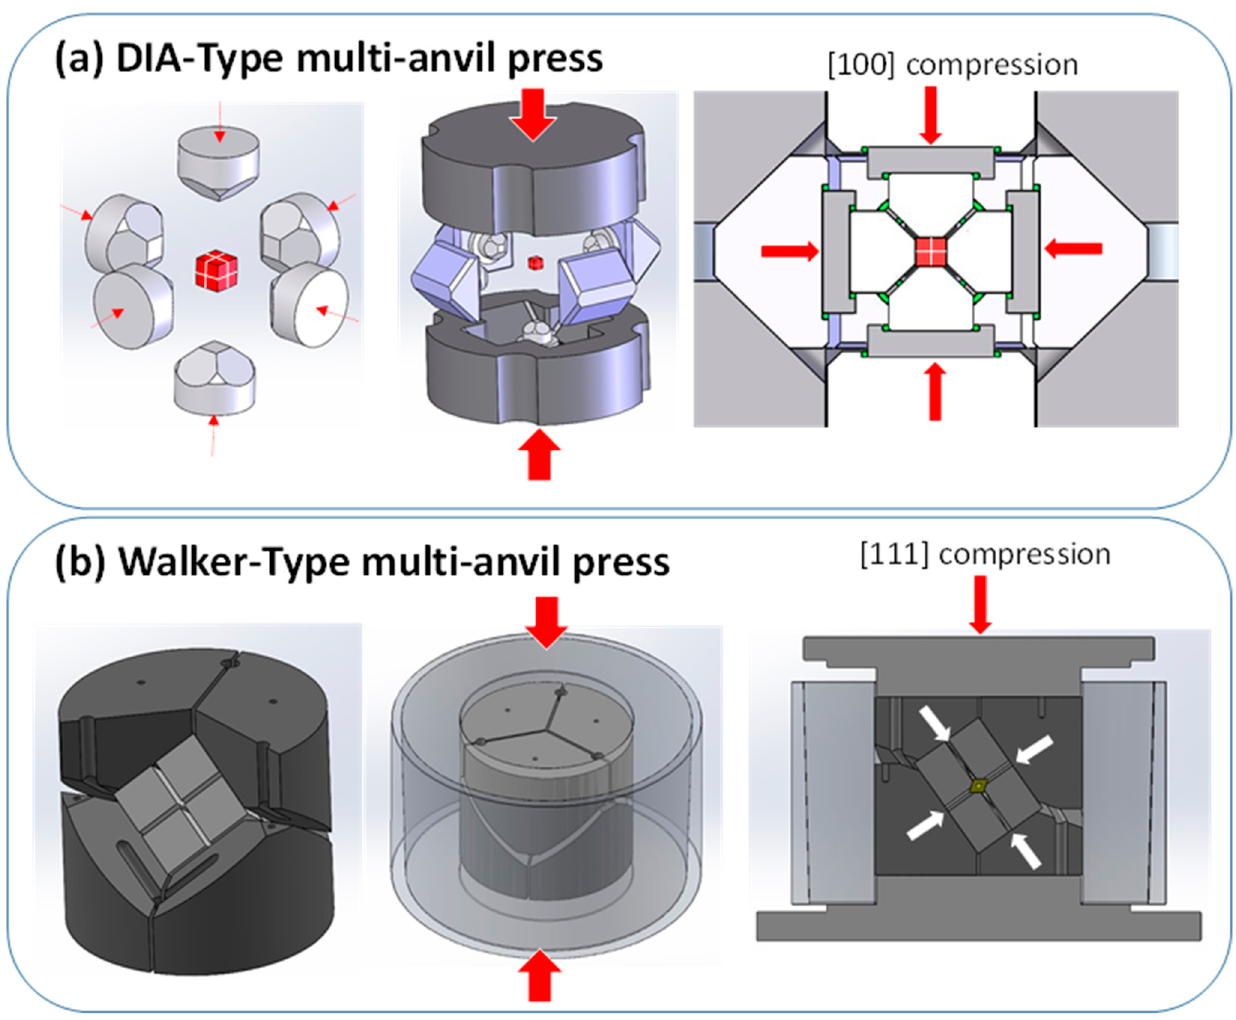
Figure 1. ( a ) Schematic view of the DIA geometry, in which the compression of the primary anvils takes place along the [001] directions of cubic assemblage of secondary WC cubic anvils. ( b ) Schematic view of the Walker geometry, in which the primary anvils are inserted in a cylindrical vessel and the primary compression happens along the [111] direction of the WC-cubes secondary-anvil assembly.